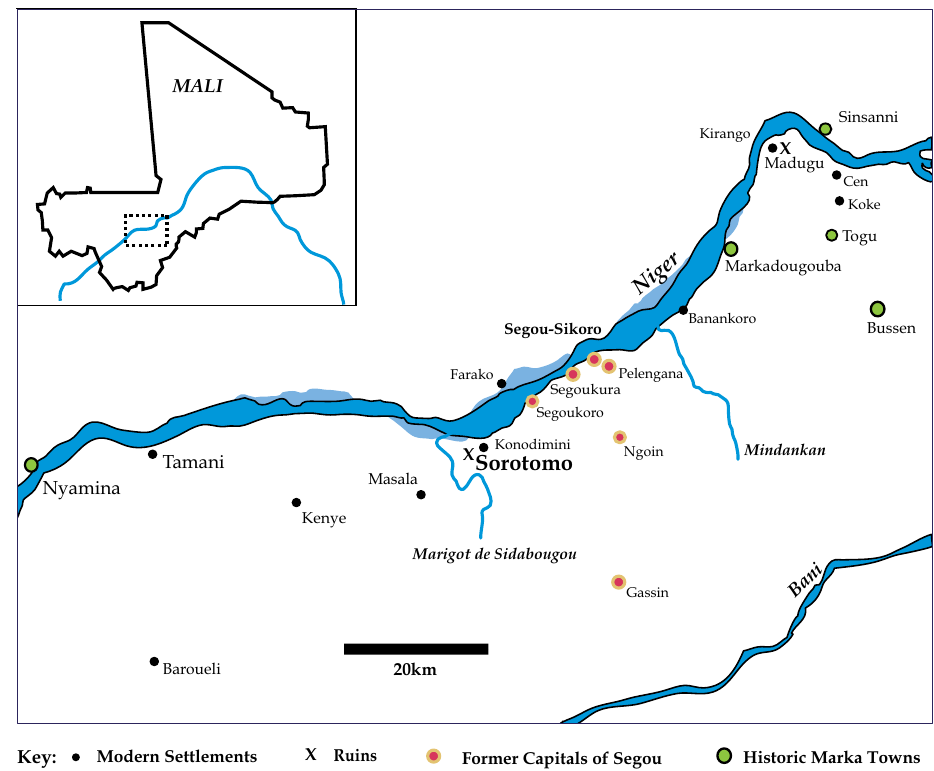
Fig. 1: Location of Sorotomo and other localities within the Segou region of